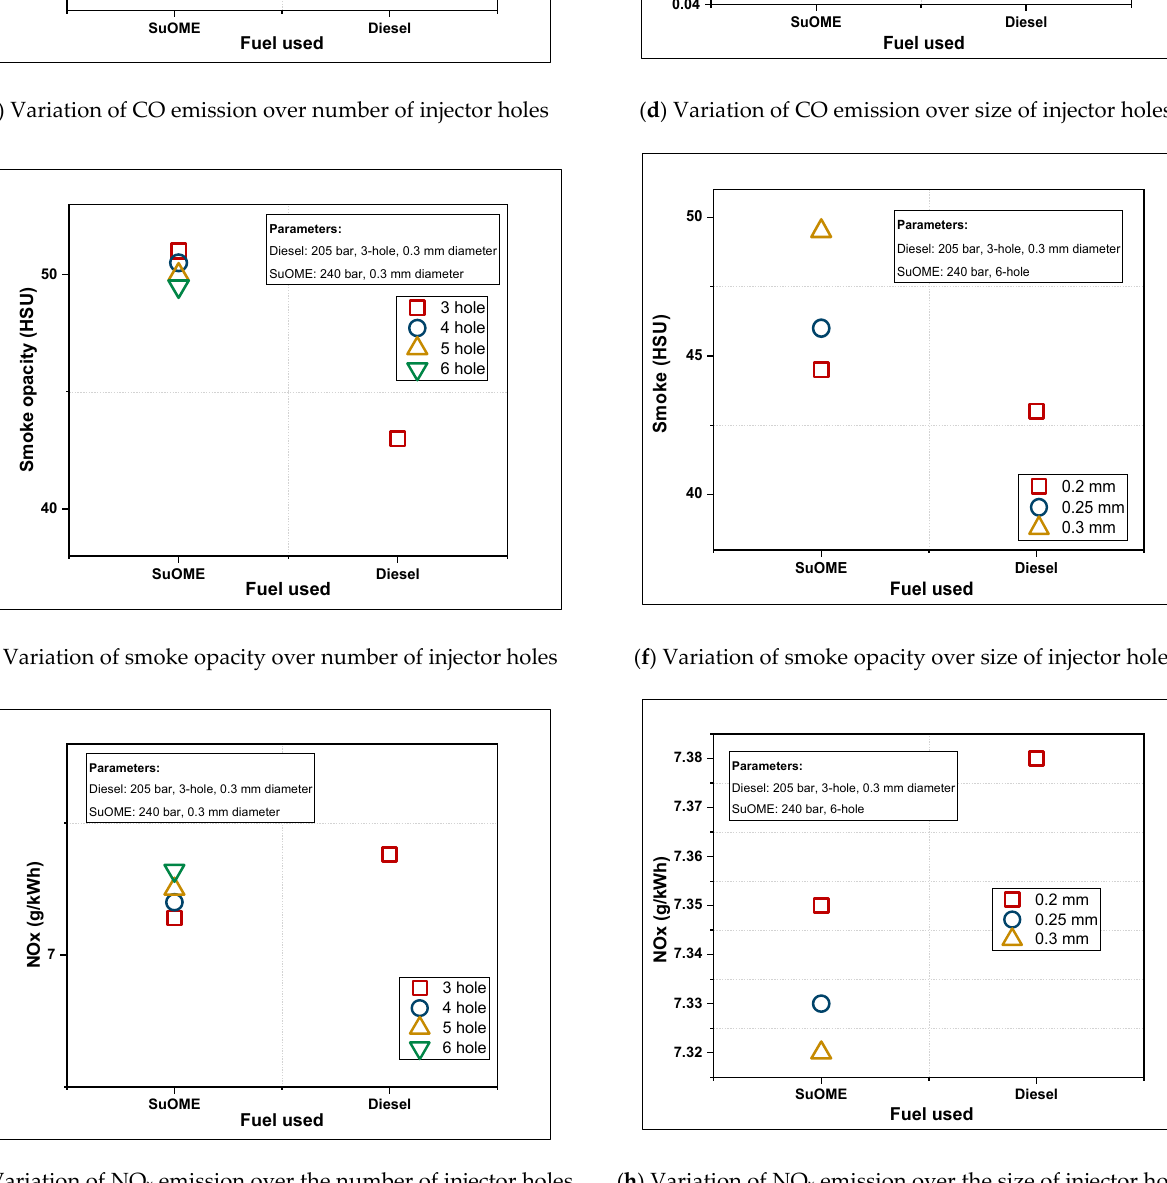
Figure 6. Variations of emissions on number of injector holes and orifice diameter of the injector: ( a ) and ( b ) HC; ( c )